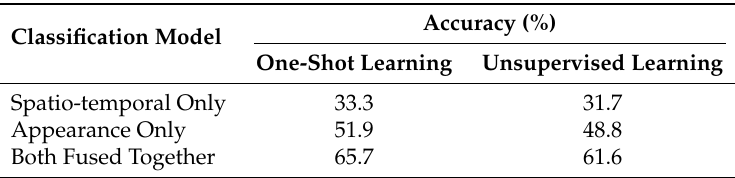
Table 1. System Accuracy with DPM for Person